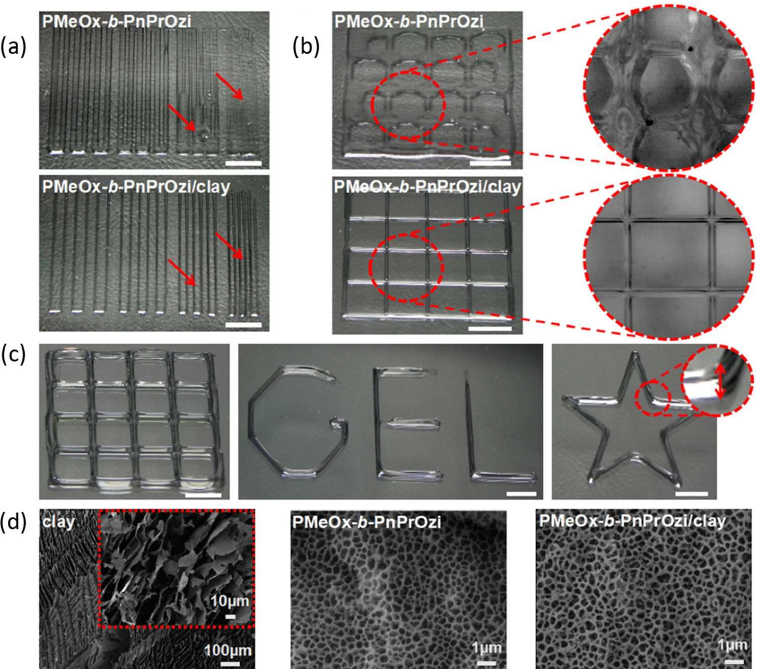
Figure 15. ( a ) 2D printed patterns for assessing the minimal strand-to strand distance and shape fidelity of biomaterial inks (red arrows are guiding for eyes). ( b ) Optical and stereomicroscopic images of the printed constructs composed with three layers of 5 × 5 orthogonal strands with a base area of 20 × 20 mm 2 (amplified in dashed red circles). ( c ) Photographic images of 3D printed six layers of a 5 × 5 woodpile structure, letters ‘‘GEL’’ and a five-pointed star with PMeOx-b-PnPrOzi/clay hydrogel. ( d ) SEM images of clay and cryo-SEM images of PMeOx-b-PnPrOzi and PMeOx-b-PnPrOzi/clay. Scale bars in ( a – c ) represent 5 mm. Reprinted with permission from [115].